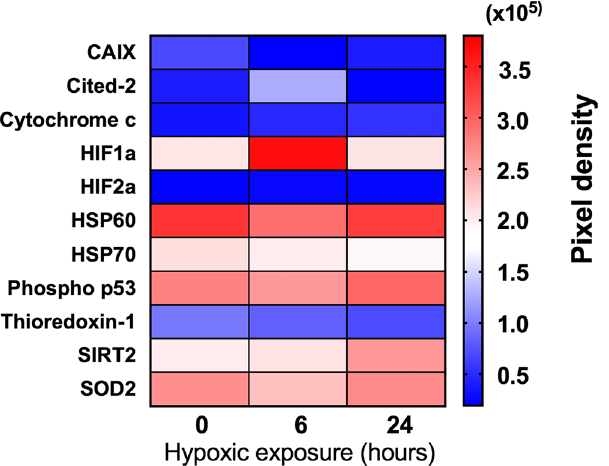
Figure 3. Impact of hypoxia on cell stress related proteins in human MDA-MB-231 breast cancer cells. Cells were conditioned in hypoxia (1% O 2 ) for either 0, 6 or 24 hours. Relative expression of cell stress related proteins in whole cell lysates using antibody protein arrays (pooled lysates from 3 samples). Full names: CAIX, carbonic anhydrase 9; Cited-2, CbP/p300 – interacting transactivator – 2; HIF1 α , α subunit of hypoxic induction factor 1; HIF2 α , α subunit of hypoxic induction factor 2; HSP60, heat shock protein 60; HSP70, heat shock protein 70; Phospho p53 (s46), phosphorylated p53; SIRT2, NAD-dependent deacetylase sirtuin-2; SOD2, mitochondrial superoxide dismutase 2